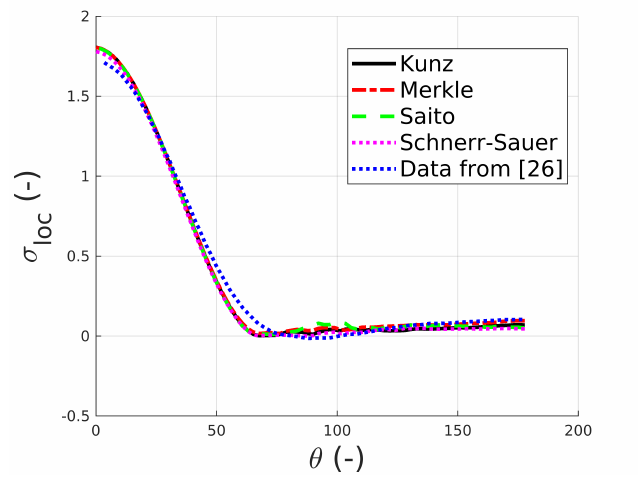
Figure 21. Time averaged local σ on the cylinder surface considering analytical-based coefficients. For all simulations, the length of the attached cavity, the length of vortex formation and the vortex shedding frequency were evaluated from the data shown, respectively, in Figures 18–20. The quantities are collected in Table 9. Table 9. Results of length of attached cavity, vortex formation length and non-dimensional vortex shedding frequency with analytical-based